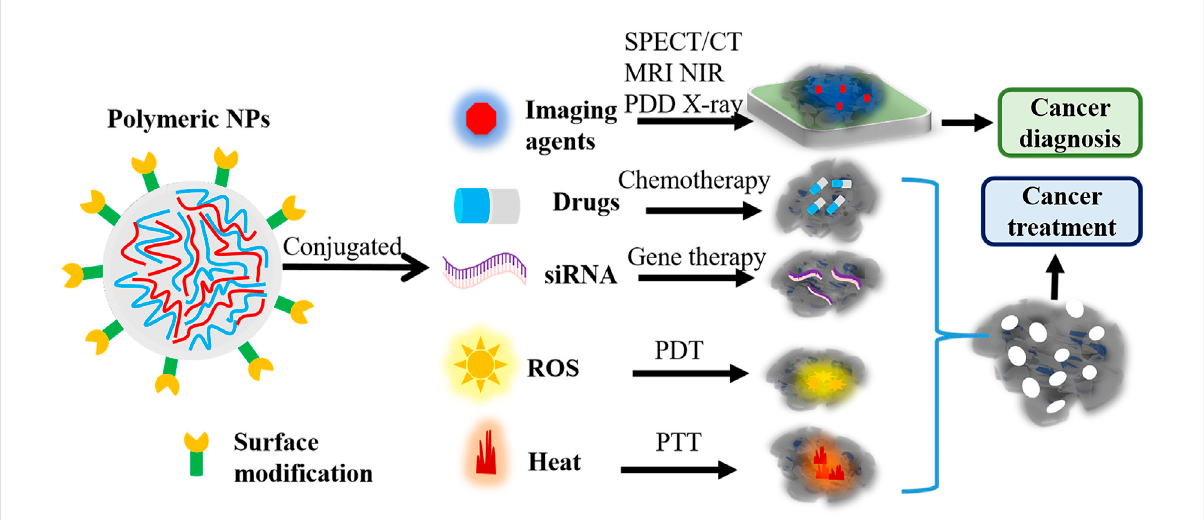
FIGURE 2 The function of polymeric nanoagents in cancer diagnosis and treatment. Polymeric NPs-based nanoagents would be widely used to guide SPECT/CT, MRI, NIR, PDD, and X-ray imaging through integrating with imaging agents. Also, these novel polymeric nanoagents can guide chemotherapy,siRNAtherapy,PTTandPDTthroughintegratingwithchemotherapeuticdrugs,siRNA,andimagingagents.NPs,nanoparticles;PDD, photodynamic diagnosis; NIR, near-infrared; PTT, photothermal therapy; PDT, photodynamic therapy; NPs, nanoparticles; ROS, reactive oxygen species; MRI, magnetic resonance imaging; CT, computed tomography; SPECT, single photon emission computed